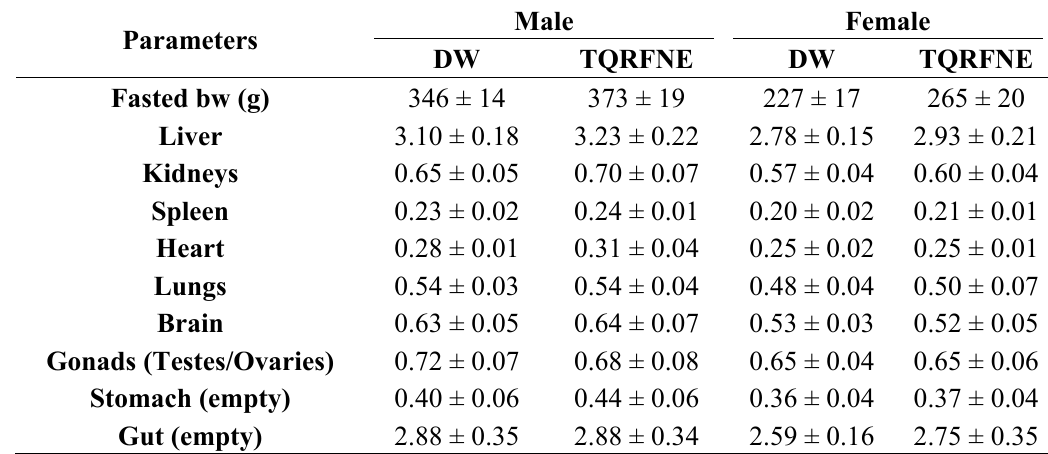
Table 1. Effects of oral administration of thymoquinone-rich fraction nanoemulsion (TQRFNE) and distilled water (DW) on mean terminal body weight (bw) and relative organ weights of male and female rats during acute toxicity study